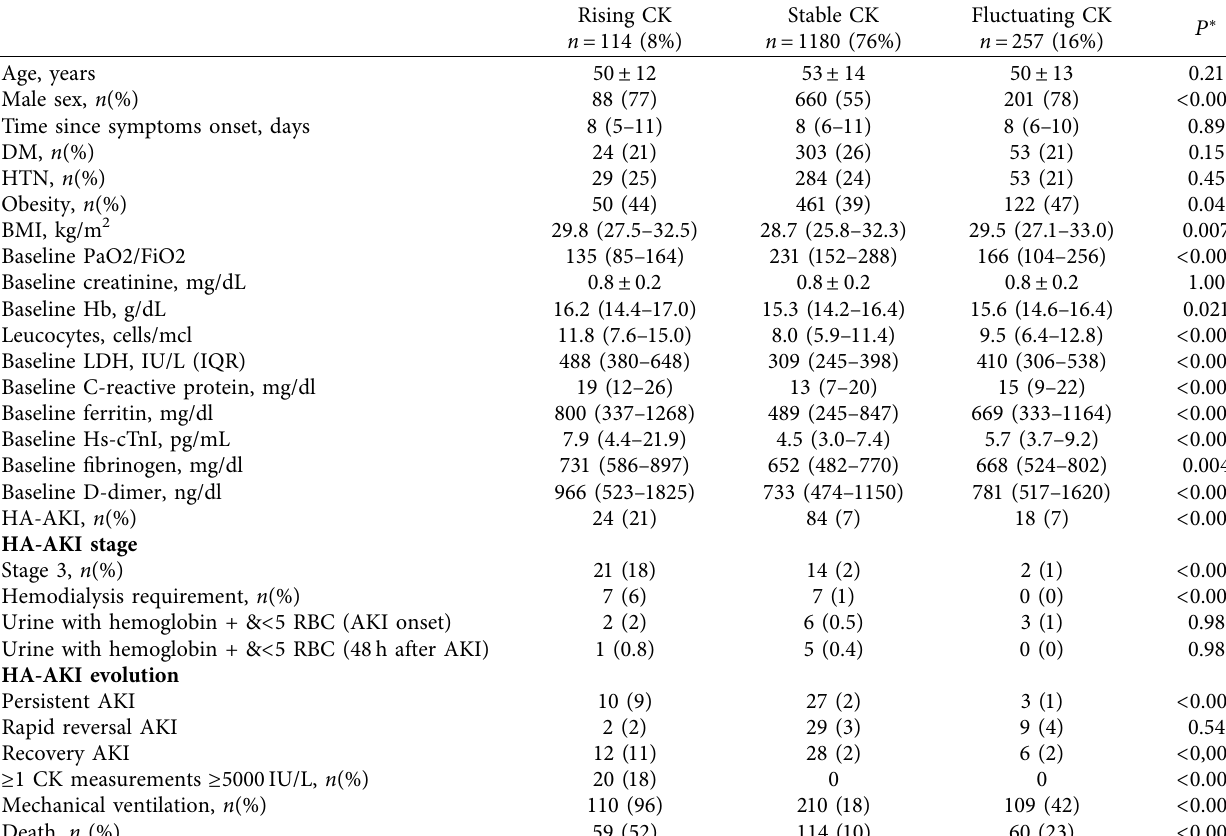
Table 2: Clinical characteristics stratified by serum CK trajectories.